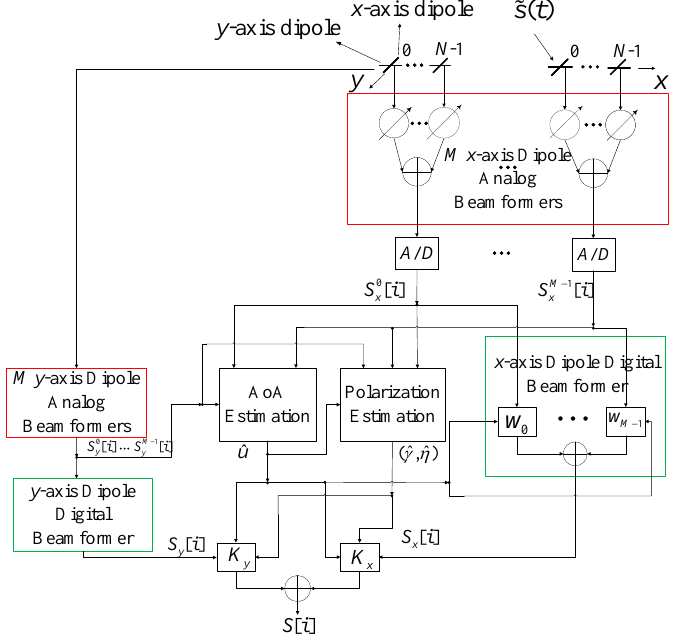
Figure 1. Illustration of linear localized hybrid dual-polarized antenna